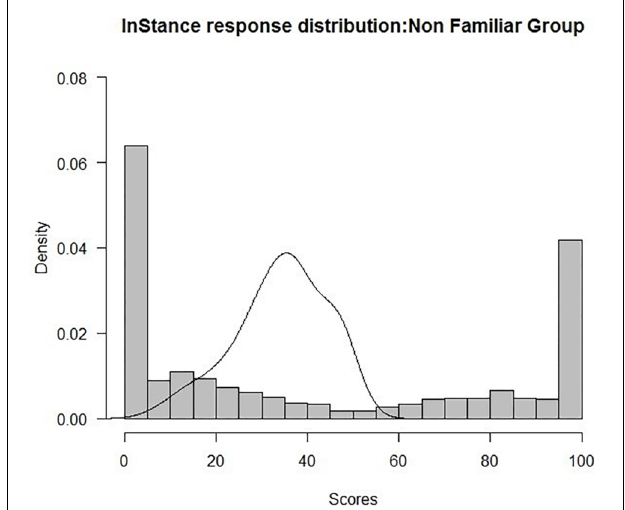
FIGURE 6 | Plot of raw data for the not familiar group ( N = 89, Shapiro–Wilk test: W = 0.81 p < 0.001).